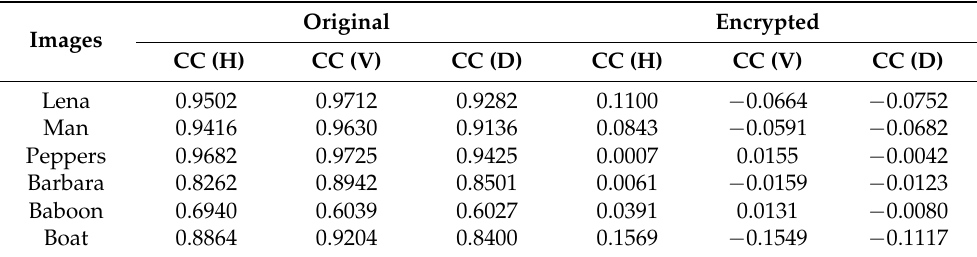
Table 3. Correlation Coefficient (CC) Horizontal (H), Vertical (V), and Diagonal (D) values for the input test images.